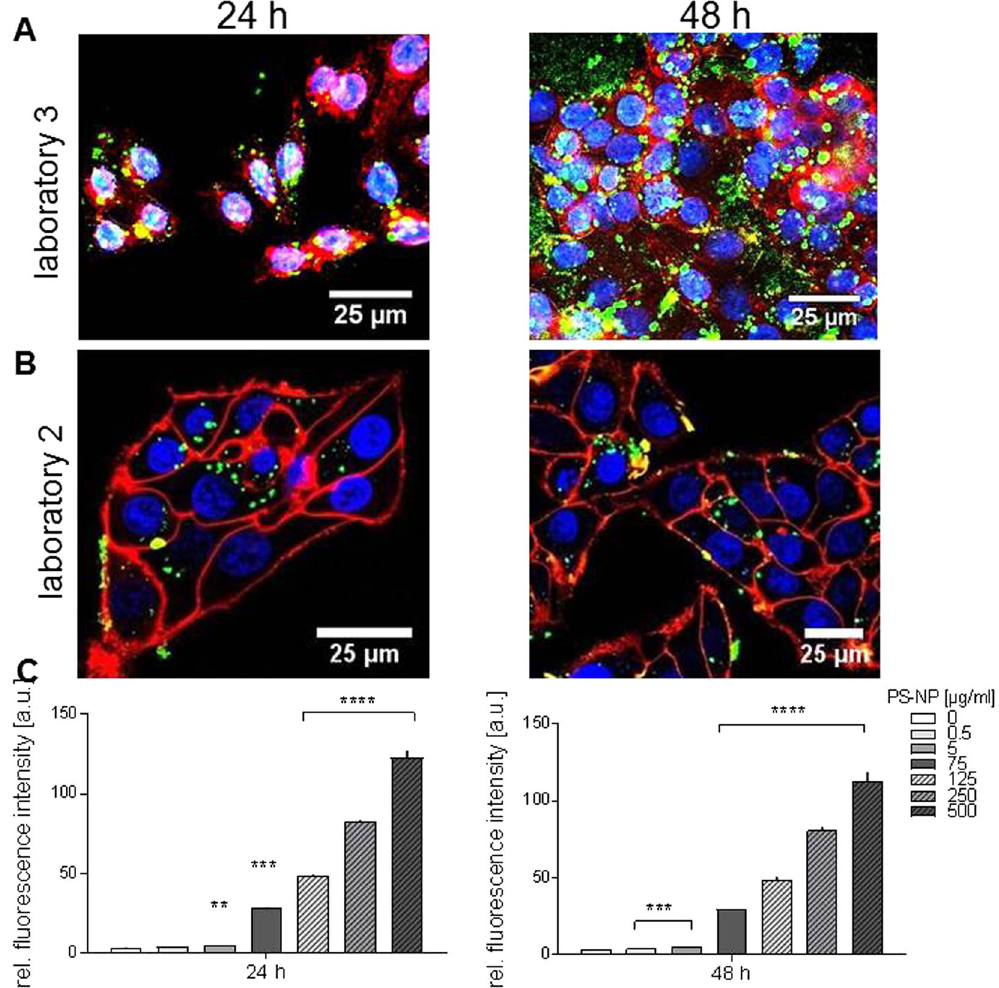
Figure 7. Internalisation of polymer NPs into cultured HepG2 cells. Confocal laser scanning microscopy images of HepG2 after treatment with 500 µ g/mL polymer-NP for 24 and 48 h in ( A ) Lab 3 and in ( B ) Lab 2. ( C ) Flow cytometry analysis of the uptake from the experiment conducted by Lab 2. Blue: nucleus, red: cell membrane, green ( ** p < 0.01; *** p < 0.001; **** p < 0.0001 compared to untreated